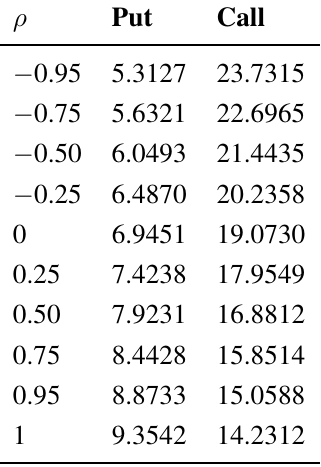
Table 4. Put and call option approximation prices for various values of ρ . (For ρ = 1 , they are Black–Scholes